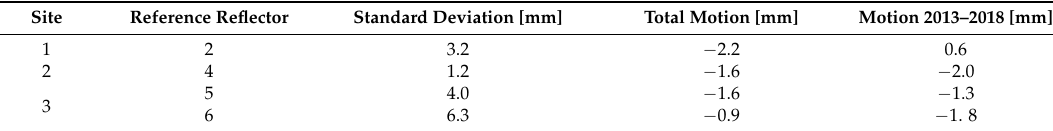
Table 5. Measured displacement of reflector 3, referenced to the four reference reflectors.